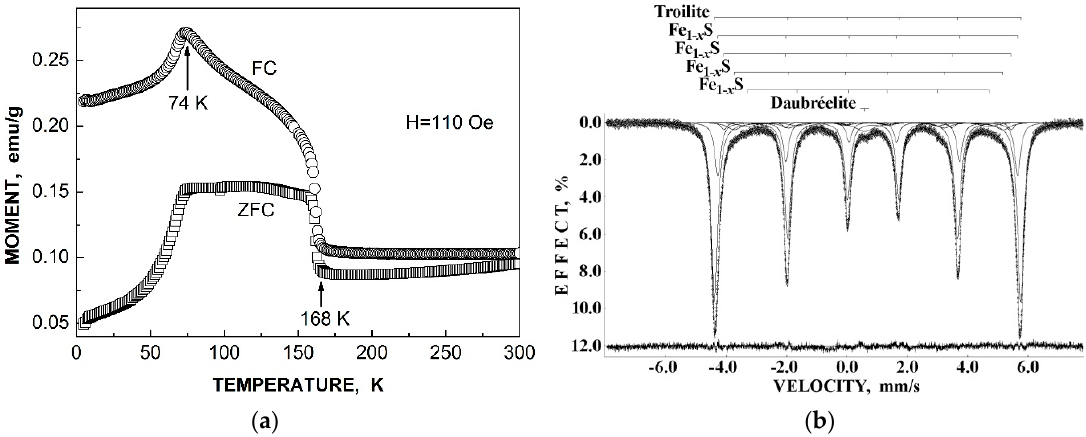
Figure 11. Troilite inclusion extracted from the Sikhote-Alin iron meteorite: ( a ) zero-field-cooled (ZFC) and field-cooled (FC) magnetization curves; and ( b ) Mössbauer spectrum measured at 295 K: indicated components are the result of the fit with a simulation of the full static Hamiltonian for the troilite component, the differential spectrum is shown below. Data adopted from [11].